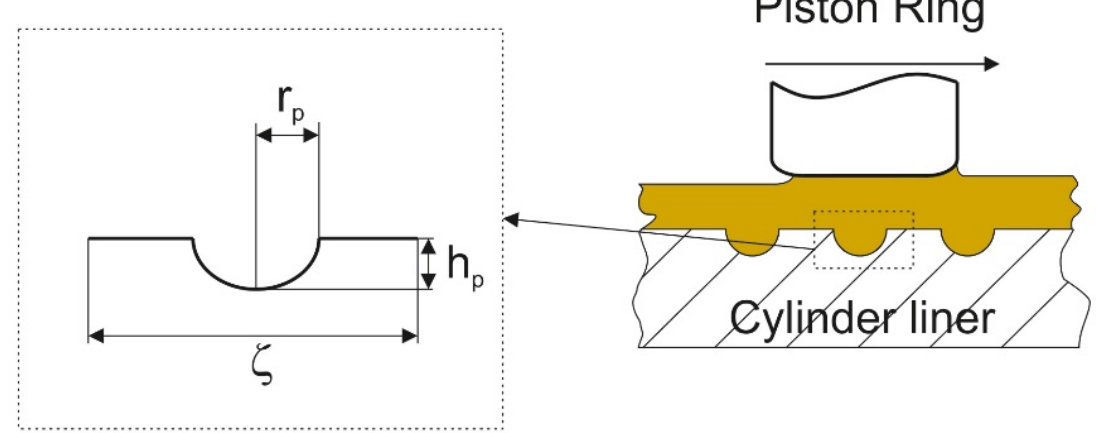
Figure 27. The scheme of contact between the cylinder liner and the piston ring, after [141].